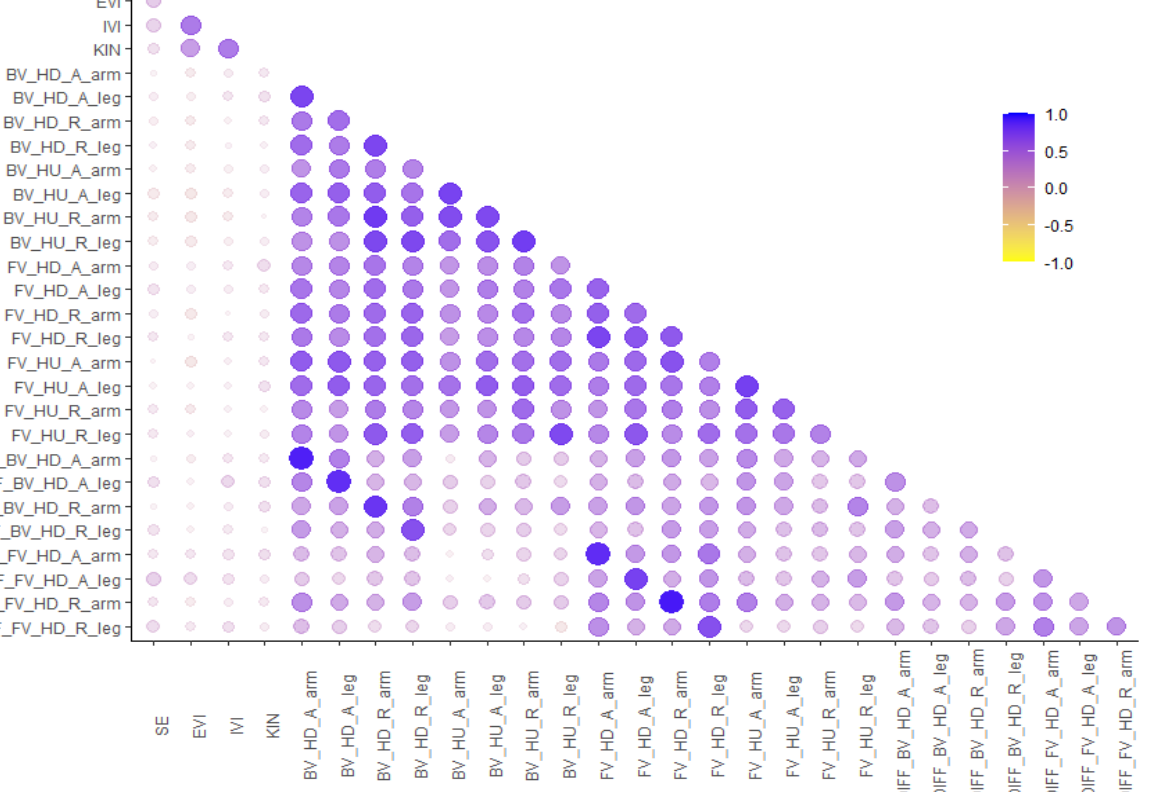
Figure 5. Pearson correlations between self-efficacy (SE; [49]) vividness of external visual (EVI), internal visual (IVI), and kinesthetic (KIN) imagery [7] and linear integrated speed-accuracy scores depending on perspective (front view: FV, back view: BV), rotation (head-up: HU, head-down: HD), abstractness (realistic: R, abstract: A), and limb (arm, leg). Additionally, correlations of the difference score (DIFF) of each condition with the baseline (back view head-up) are shown. Larger and darker circles indicate larger correlations.